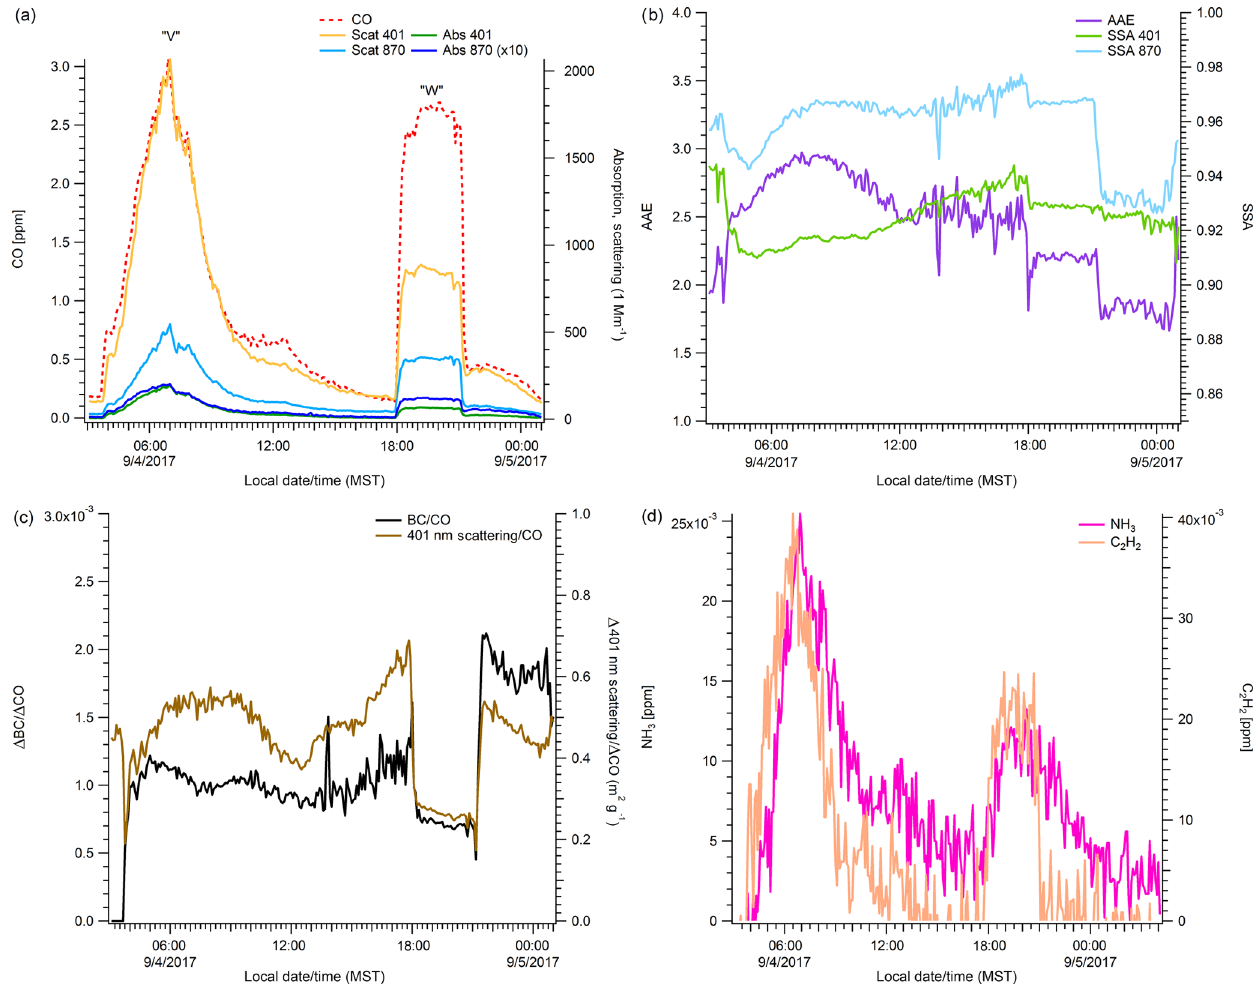
Figure 6. High-resolution (5min) time series of smoke impacts measured in Missoula over Labor Day weekend (see Sect.